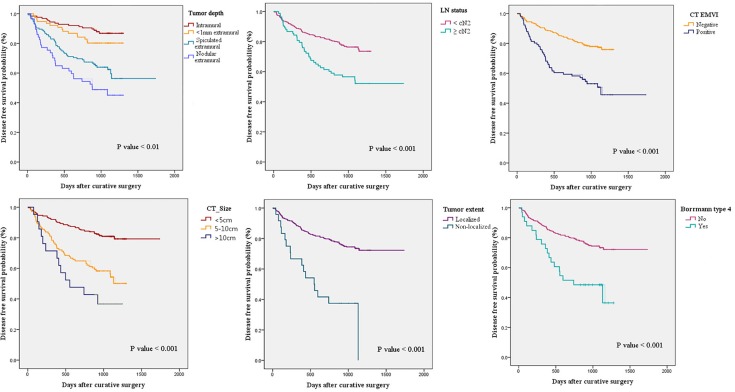
Kaplan-Meyer curves for disease free survival stratified to variable radiologic parameters.DFS was significantly worse in patients with CT findings of more advanced CT-tumor depth, CT-LN status, CT-detected EMVI, large size, non-localized longitudinal extent, and Borrmann type 4.